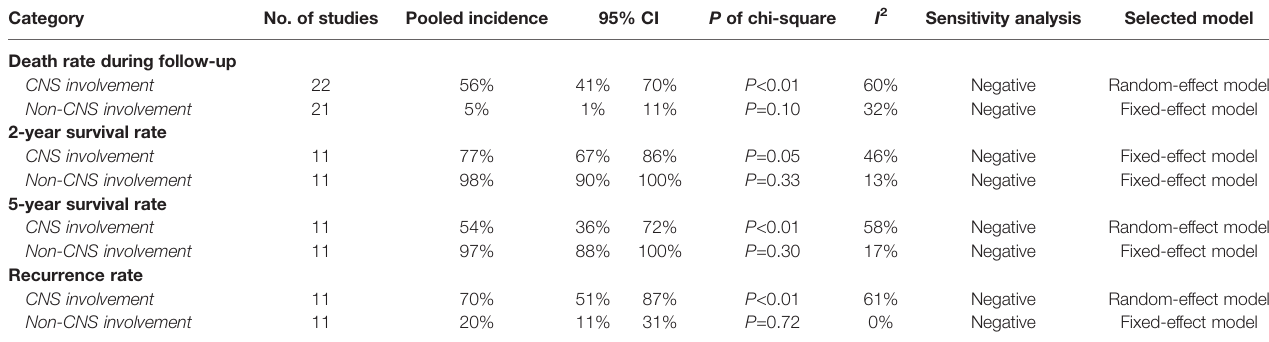
TABLE 4 | Pooling results about prognosis of PIOL patients with and without CNS Involvement.